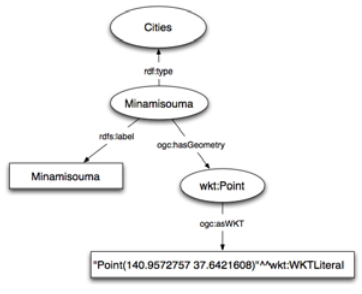
Figure 6. An example of Spatial RDF